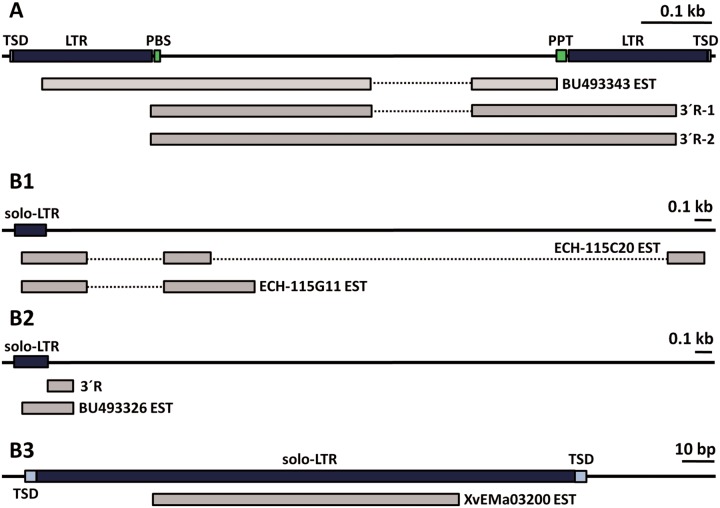
Transcription of ta-TRIM and derived elements in E. multilocularis. Continuous lines indicate the genomic loci, and EST and 3′-RACE (3′ R) data are shown below, with mapped regions drawn as gray rectangles, and intervening introns as dotted lines connecting them. (A) Example of a full length ta-TRIM. (B1–B3) Examples of solo-LTRs initiating the transcription of diverse noncoding RNAs (see the main text for details).